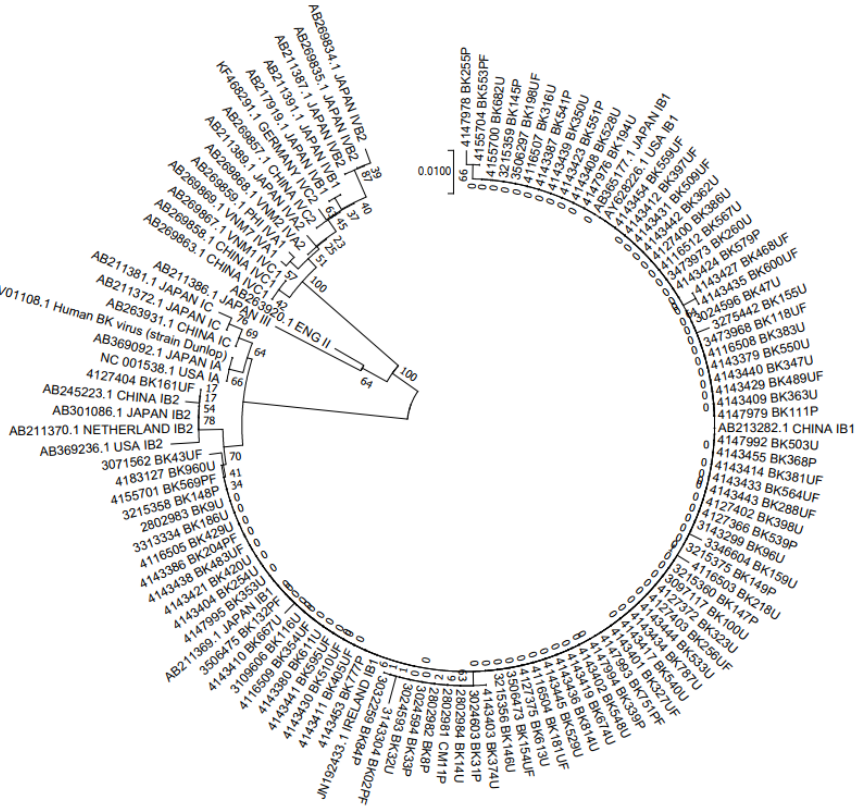
Figure 1. NJ phylogenetic tree clustering of 90 BKV-I polyomavirus sequences to determine subgroups.